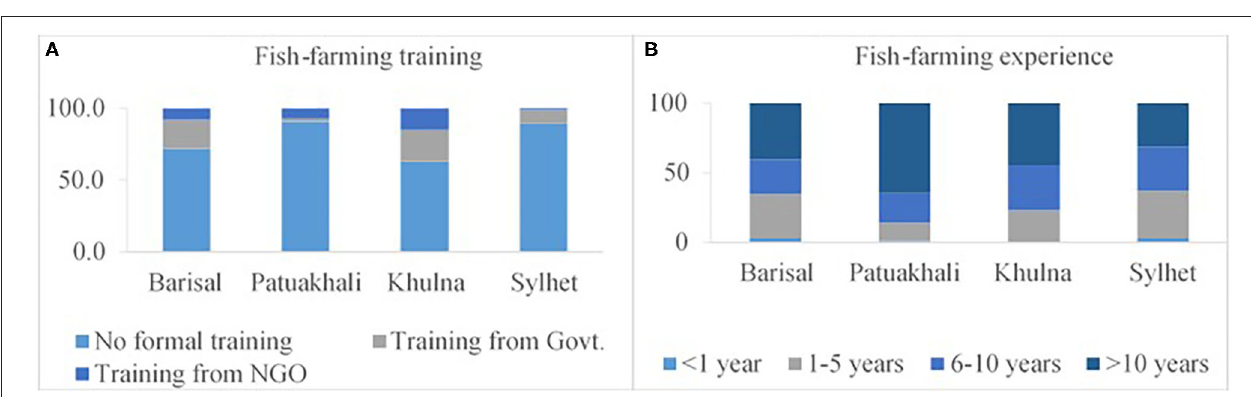
FIGURE 4 | Overview of fish-farmer type in the studied regions by percent of